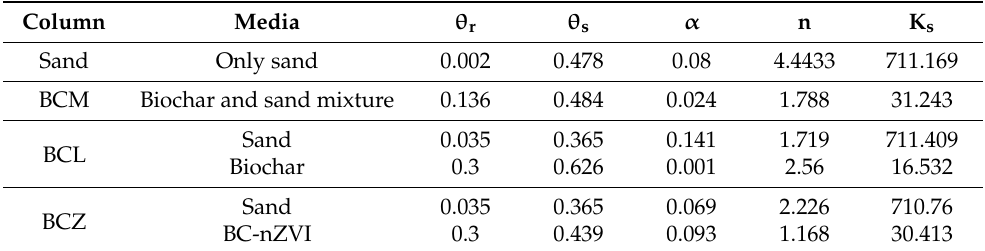
Table 3. Hydraulic parameters determined by the HYDRUS 2D inverse